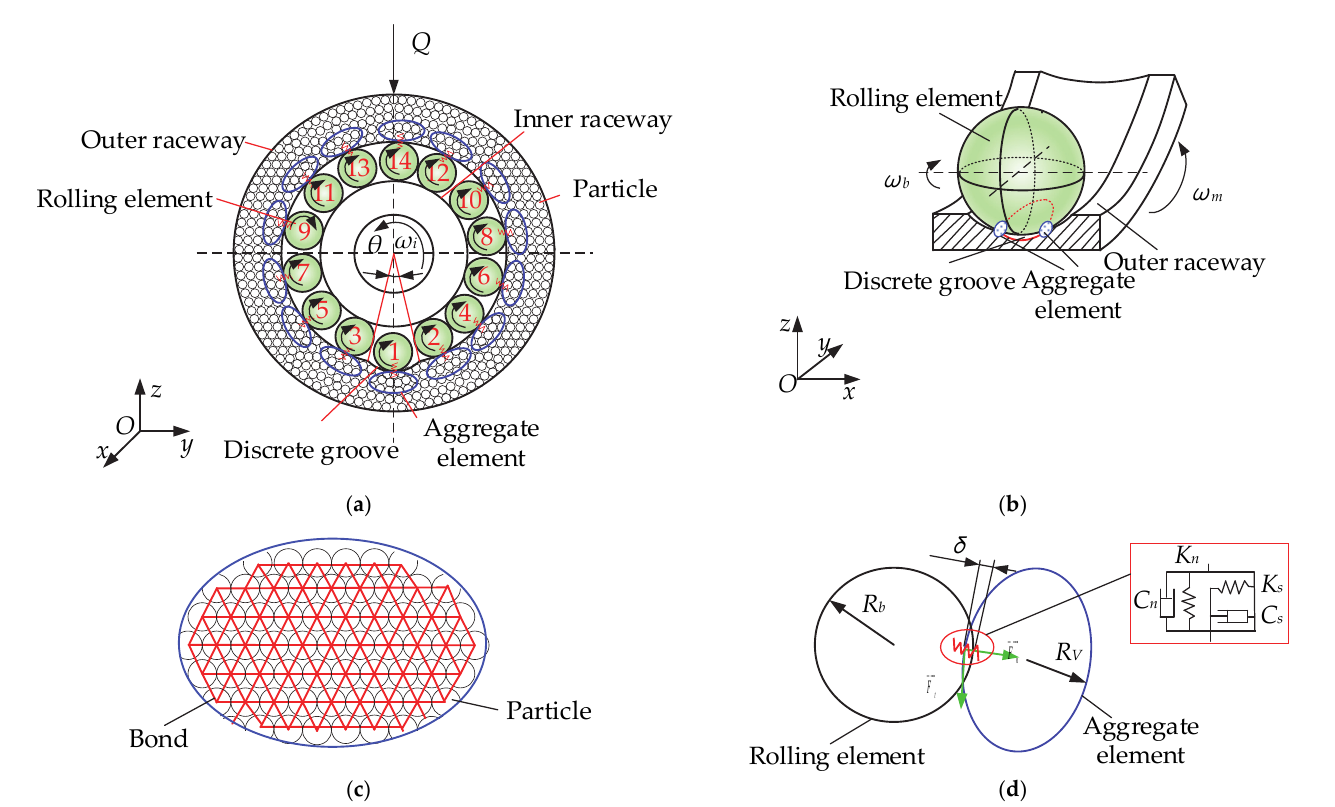
Figure 1. Discrete element model of cageless ball bearing: ( a ) discrete element model with rolling elements 1–14; ( b ) contact between rolling element and aggregate element; ( c ) aggregate element; ( d ) contact model of rolling element and aggregate element.